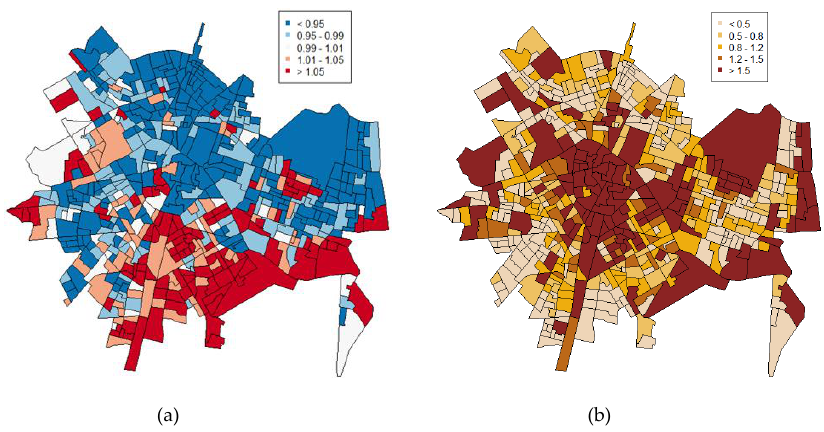
Figure 3. ( a ) Change in alcohol-related calls-for-service from 2010 to 2015; and ( b ) the relative risk of alcohol-related calls-for-service in